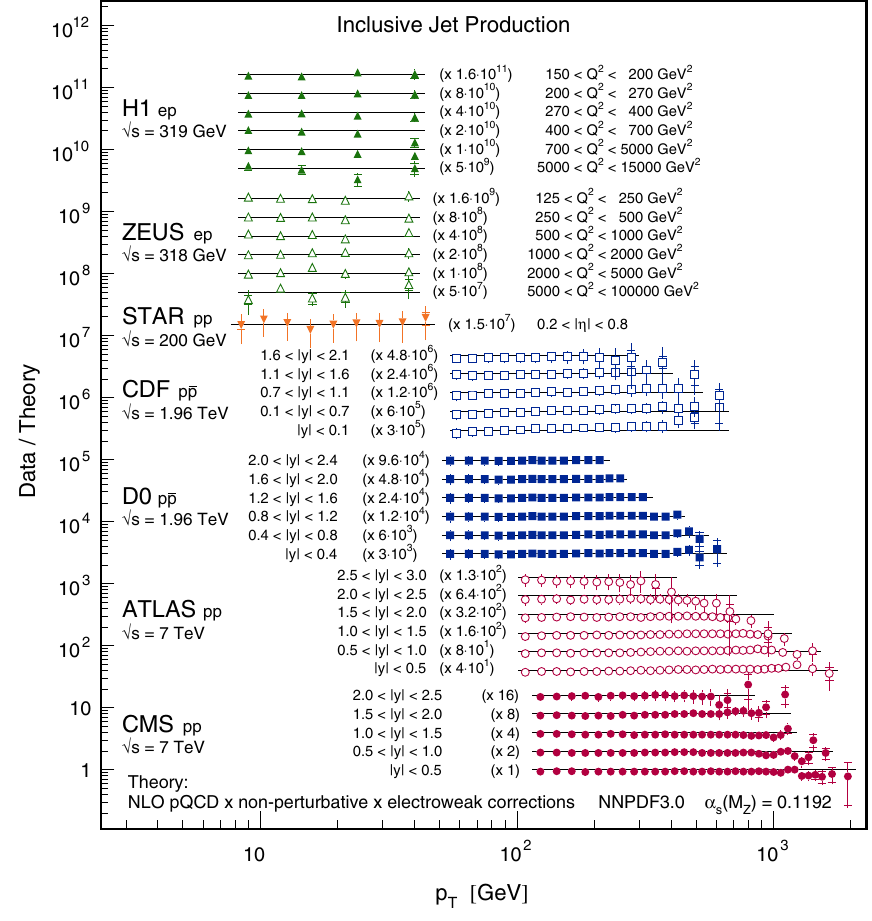
Fig. 5 Ratio of data over theory for the selected inclusive jet cross sections listed in Table 2 as a function of jet p T . The NLO predictions are computed with the NNPDF3.0 PDF set for the fitted α s ( M Z ) value of 0 . 1192, which is determined considering all presented data except for the ATLAS data